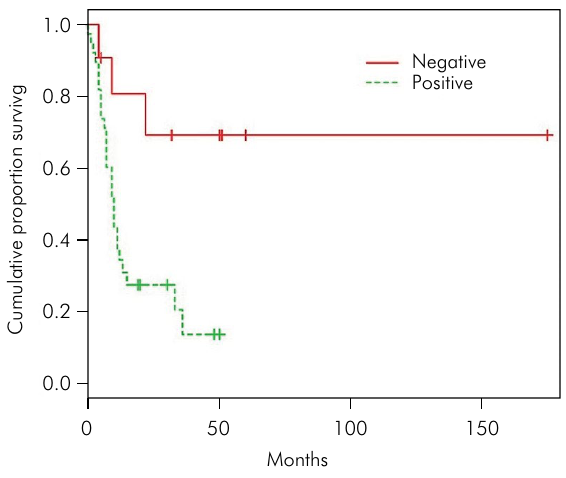
Figure 4. Kaplan-Meier curve showing the differences between Ki-67 positive and negative expression ( p